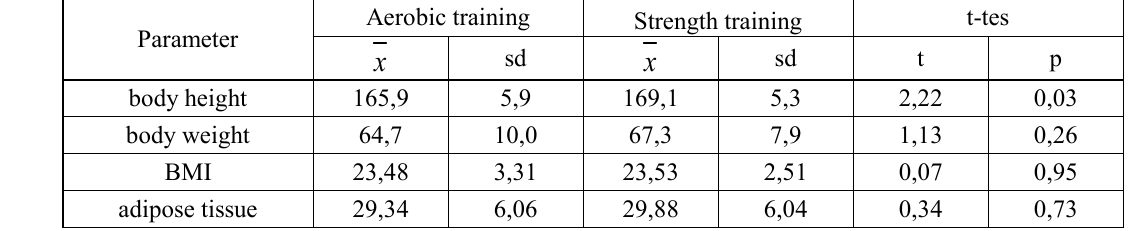
Somatic parameters comparison in subjects participating in aerobic and strength training (preliminary measurement)